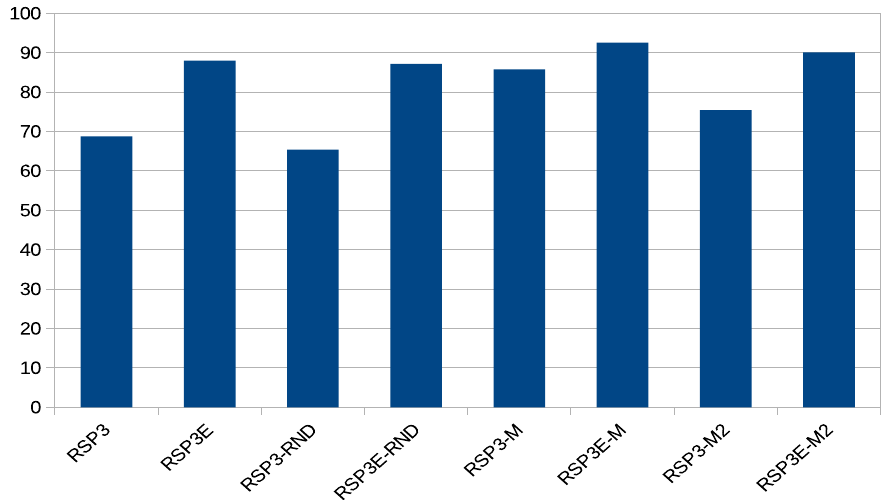
Figure 5. Average reduction rates measurements.